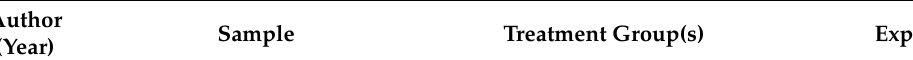
Table 3. Summary of studies included in this systematic